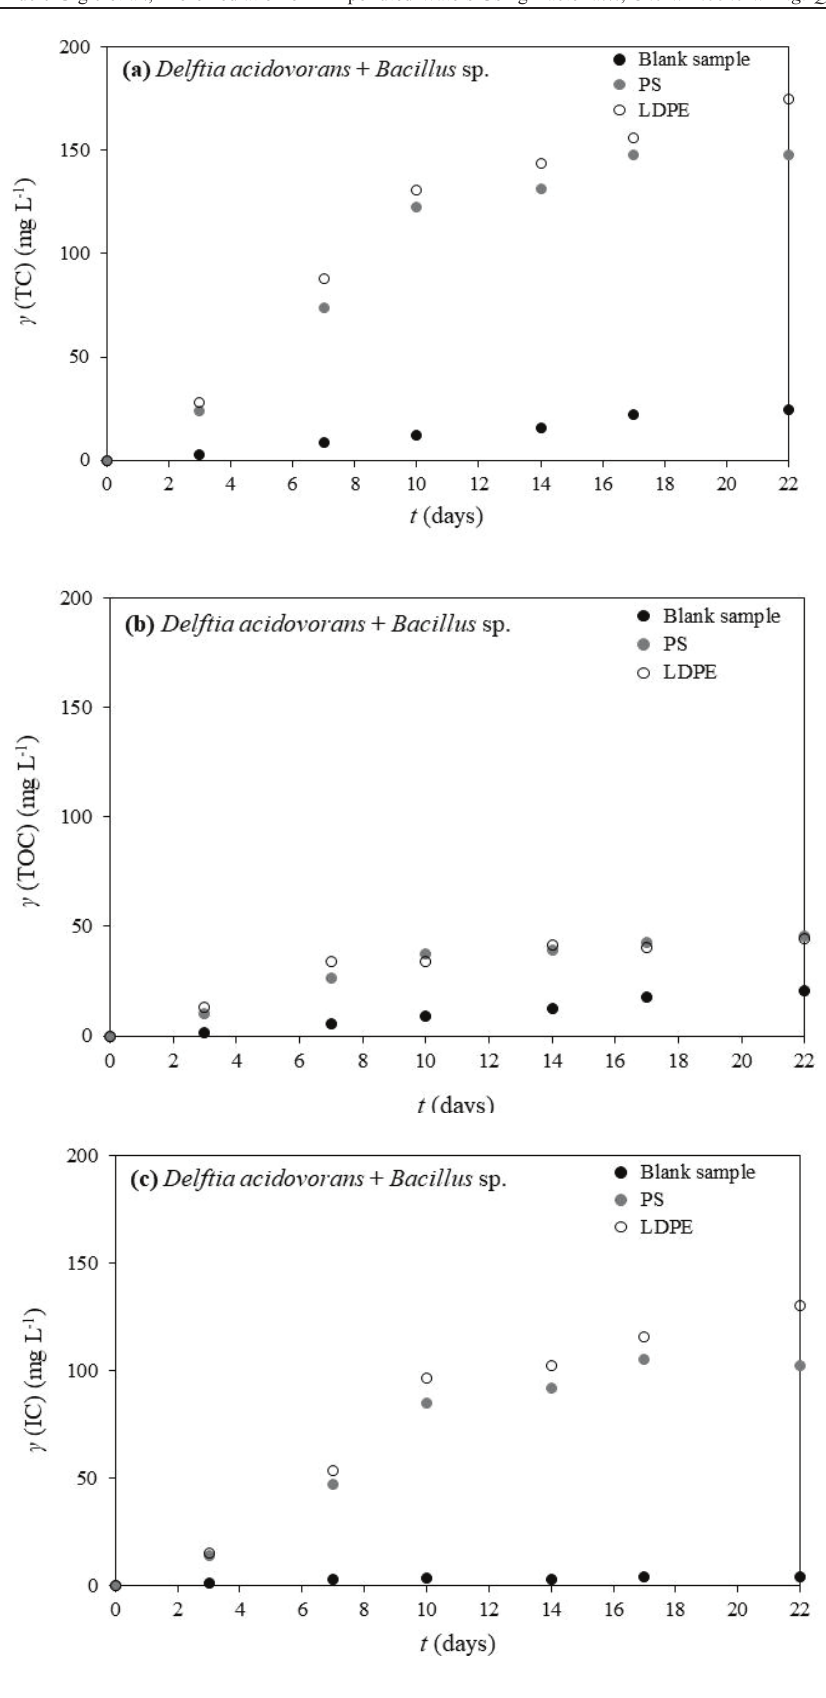
Fig. 7 – Changes in TC (a), TOC (b) and IC (c) concentration during biodegradation of MP-LDPE and MP-PS with mixed bacte- rial culture of Bacillus sp. and Delftia acidovorans in sterile Erlenmeyer flasks during 22 days (Vr = 100